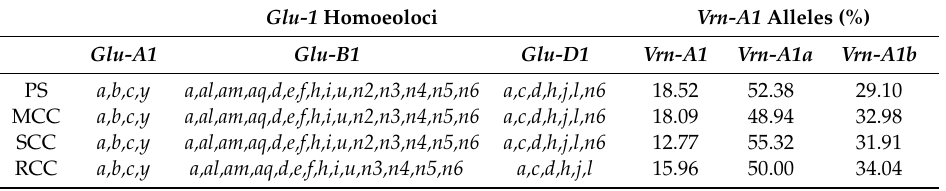
Table 4. Alleles at the Glu-1 homoeoloci and gene Vrn-A1 in the primary set and the core